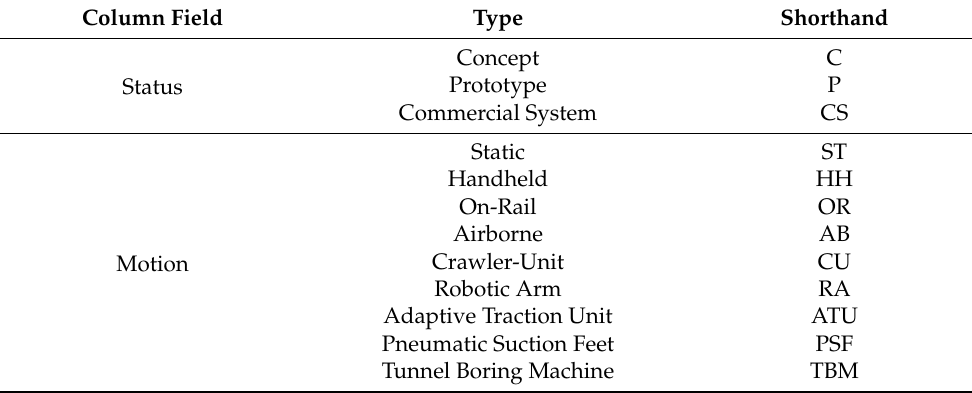
Table A2. Literature Summary Tables: Shorthand